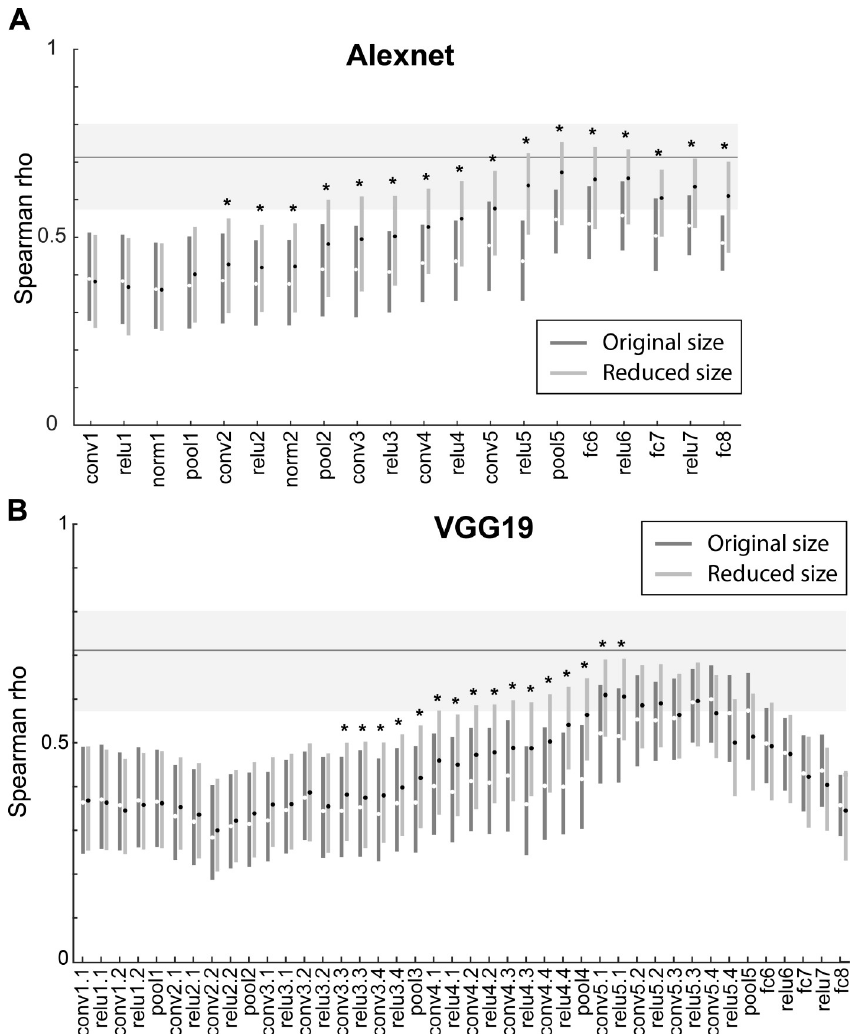
Fig 5. Representational similarity analysis of deep CNN layers and IT neurons for the whole shape set with two different sizes. Spearman rank correlation coefficients between IT and model layer similarities are shown for each layer of Alexnet (A) and VGG19 (B) for the original and twofold smaller sizes (“reduced size”). The dissimilarities were Euclidean distances. Error bars depict 95% confidence intervals, determined by 10,000 bootstrap samples of the IT neuron pool (n = 119 neurons). Stars indicate layers for which the Spearman rank correlations for the trained version differed significantly from its untrained version (paired bootstrap test; False Discovery Rate corrected q < 0.05). The horizontal line and gray band indicate the median and 95% interval, respectively, of the Spearman-Brown corrected split-half correlations (n = 10000 splits) of the neuronal distances, as an estimate of the noise